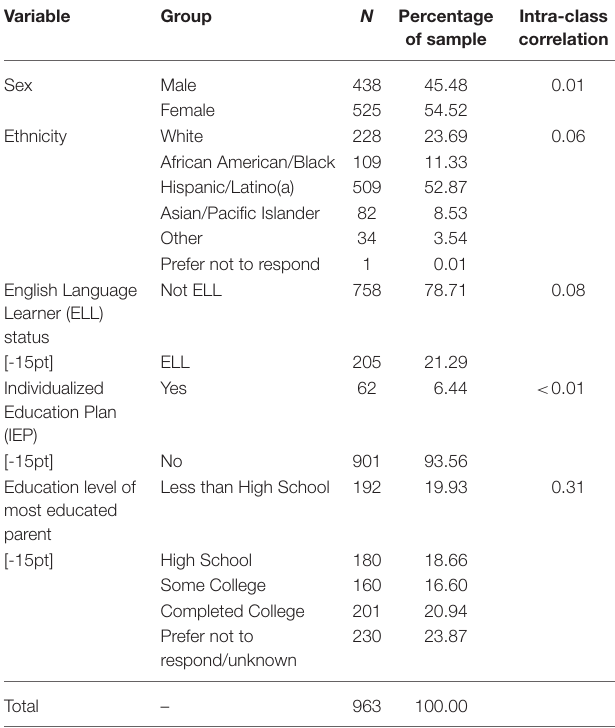
TABLE 2 | Mean, standard deviation, internal consistency, and intraclass correlation of measure